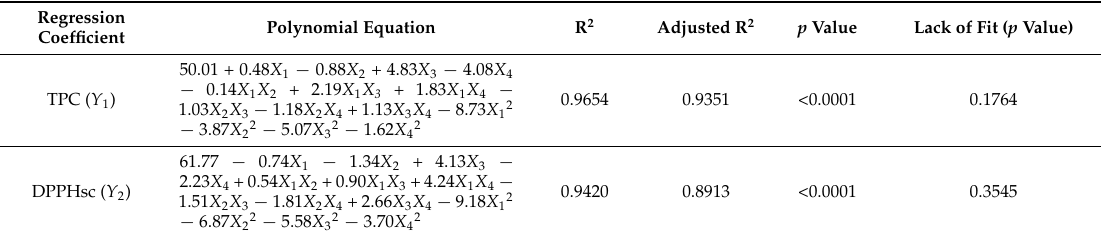
Table 3. Polynomial equation and statistical parameters calculated after implementation of CCD design. Regression